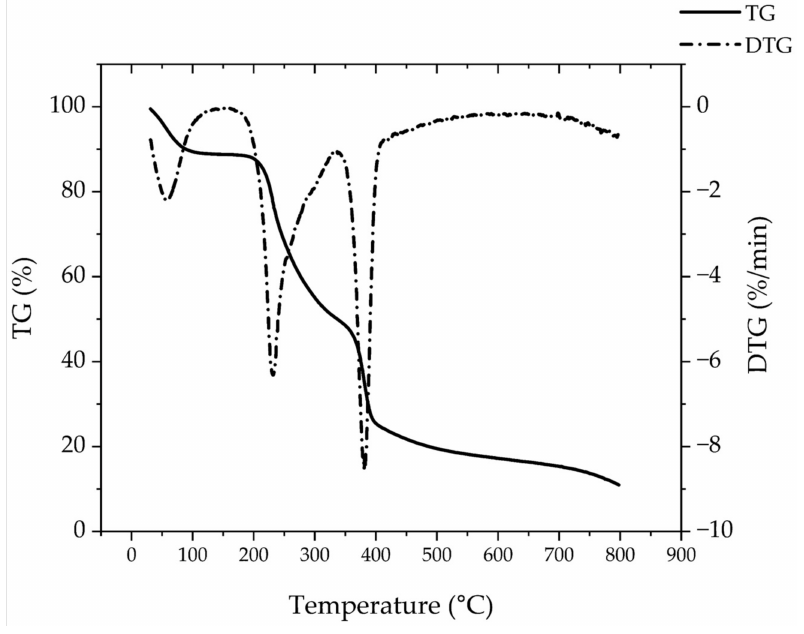
Figure 4. TGA graph of PNCDHA